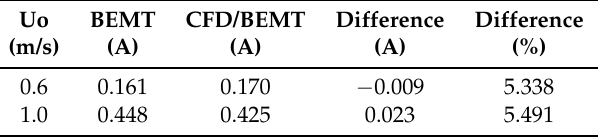
Figure 15. Generator phase current at Uo = 1.0 m/s. for ( a ) 15 s and ( b ) between 10.0 s and 10.5 s. Table 10. Generator phase current (RMS).